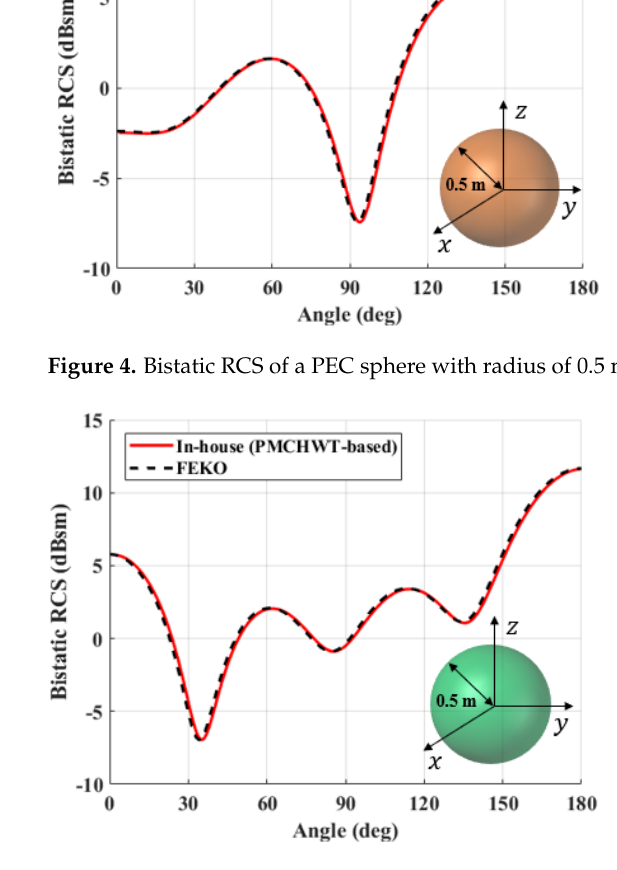
Figure 5. Bistatic RCS of a dielectric sphere with radius of 0.5 m.